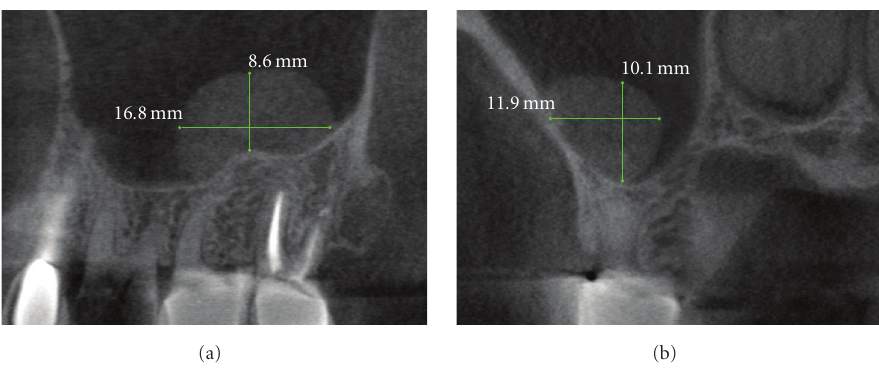
Figure 9: Antral mucosal pseudocysts, also called mucus retention cysts, are a relatively common localized dome-shaped antral mucosal swelling, often of allergic origin and while they can occur anywhere in the sinus present diagnostic challenges when associated with the floor of the maxillary sinus. CBCT imaging ((a) sagittal, (b) cross-sectional) can be useful in di ff erentiating these lesions from periapical mucositis in that the former is usually not associated with disruption of the floor of the sinus and expansion superiorly from the apex of roots of adjacent